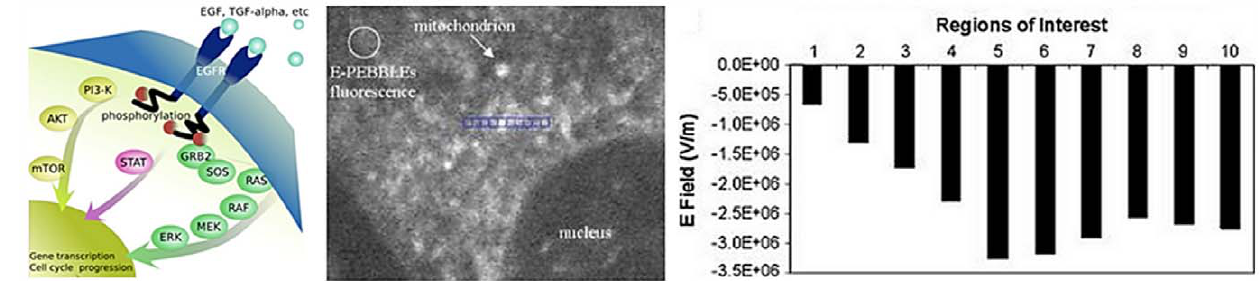
Figure 1. The EGFR pathway and intracellular electric field. (Left) Typical presentation of EGFR pathway. The proteins are not drawn to scale and, as a result, the limitation of random walk in allowing rapid and reliable transmission of information by random walk is underestimated. In fact, the distance from the cell membrane to the nucleus is about 1,000 protein diameters. (Right) Measurements of the intracellular electric field using nano-voltmeter from Tyner et al. [10]. The 10 E-field values in the bar graph on the right are those within the respective 10 blue boxes on the left. Note the decline in the electric field with distance from the nuclear membrane as well as the local perturbation caused by the presence of a mitochondria on regions 5, 6, and